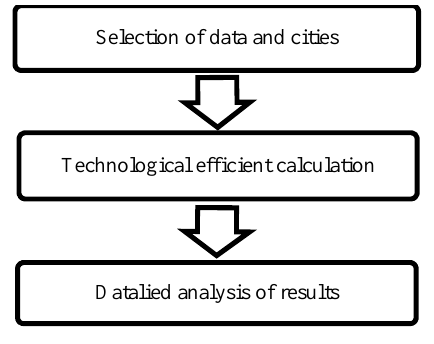
Figure 1. The scope of the research process